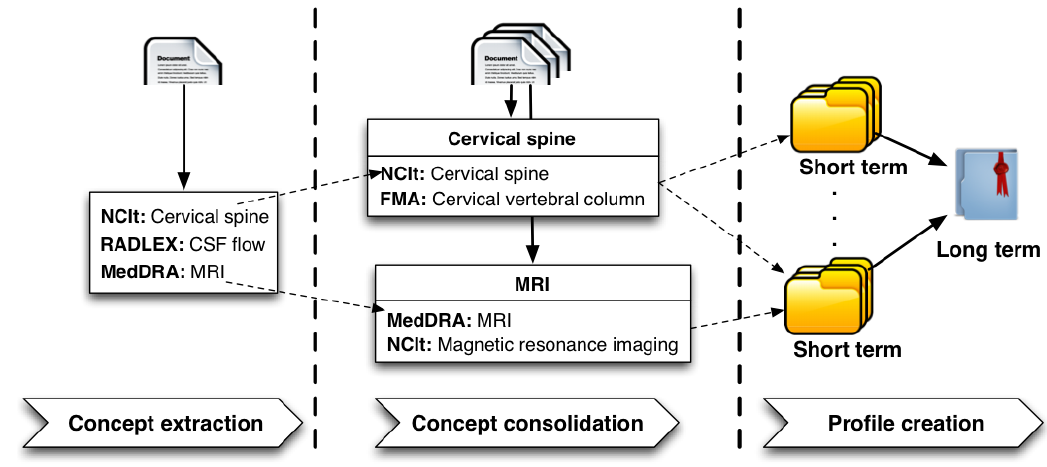
Figure 1. Semantic and time-dependent expertise profiling